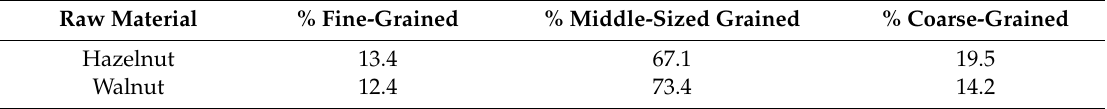
Table 1. Weight distribution according to the fraction size of the raw